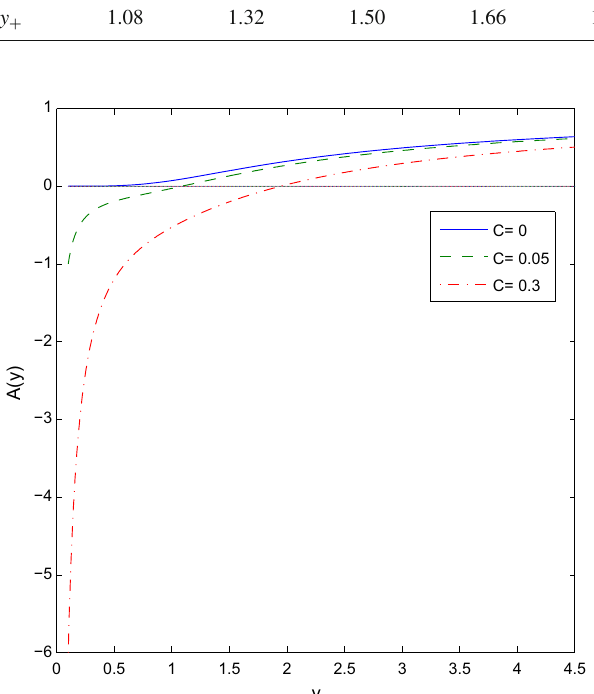
√ Fig. 3 The plot of the function T H q m β 1 / 4 vs y + . The dashed curve corresponds to C = 0 . 05, the solid curve is for C = 0, and the dash- dotted curve corresponds to C = 0 .